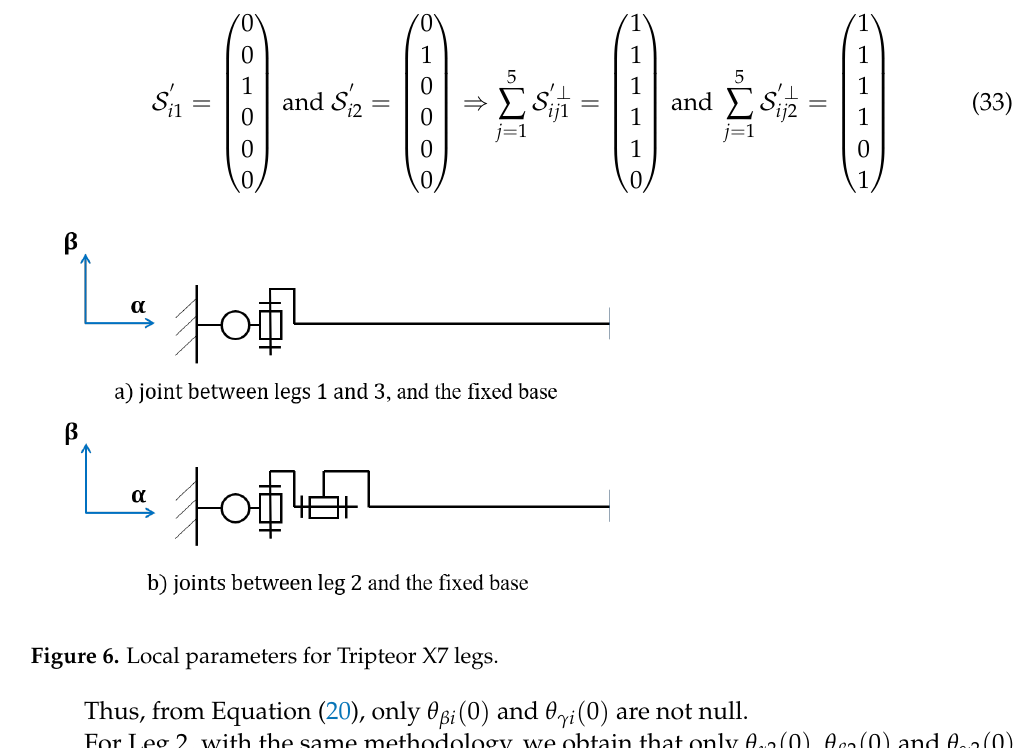
Figure 6. Local parameters for Tripteor X7